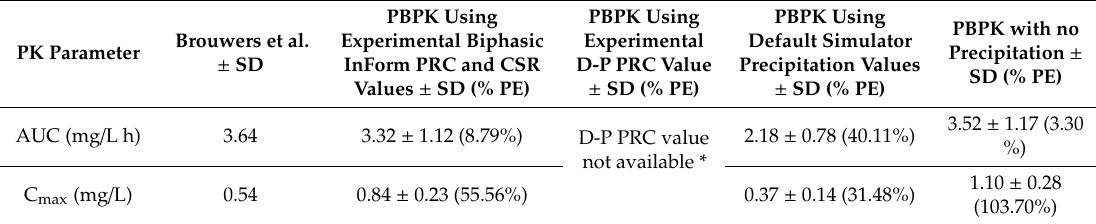
Table 6. Observed and modelled drug exposure pharmacokinetic parameters for 200 mg dose of Sporanox oral solution.